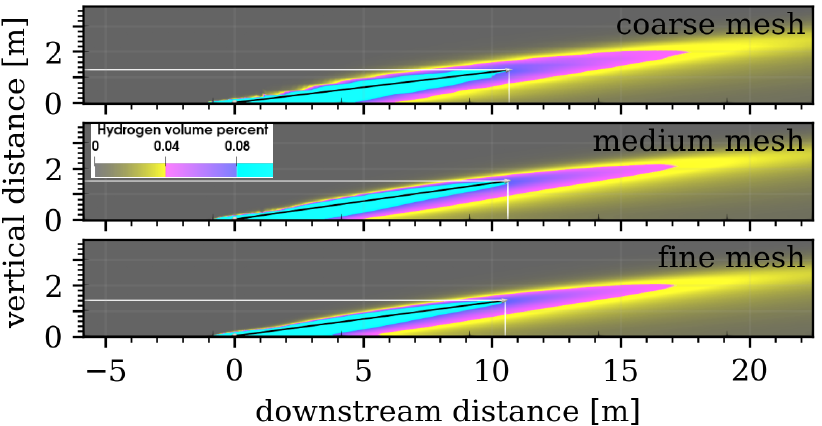
Figure 6. Profiles along the centerline of the Thunder Pipe for a 1.34 m/s crosswind and the 0.85 m pool with different mesh